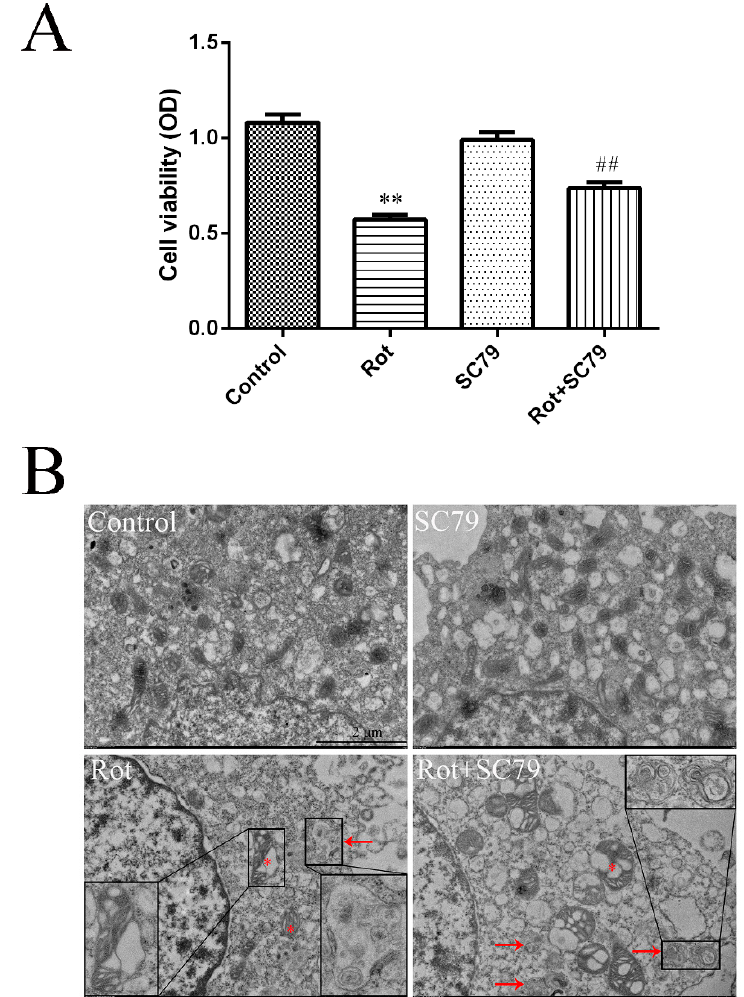
Figure 5. The activation of Akt / mTOR by SC79 protected SH-SY5Y cells from rotenone injury. SH-SY5Y cells were incubated with rotenone and SC79 for 24 h. ( A ) Cell viability was measured through a CCK-8 (cell counting kit-8) assay, and the absorbance (optical density, OD) was measured by spectrophotometry at 450 nm. ** p < 0.01 versus control group; ## p < 0.01 versus rotenone group ( n = 18). ( B ) Representative TEM images of SH-SY5Y cells treated with rotenone and SC79. Asterisks indicate degenerated mitochondria. Arrows indicate autophagic vacuoles. Scale bar = 2 μ m.